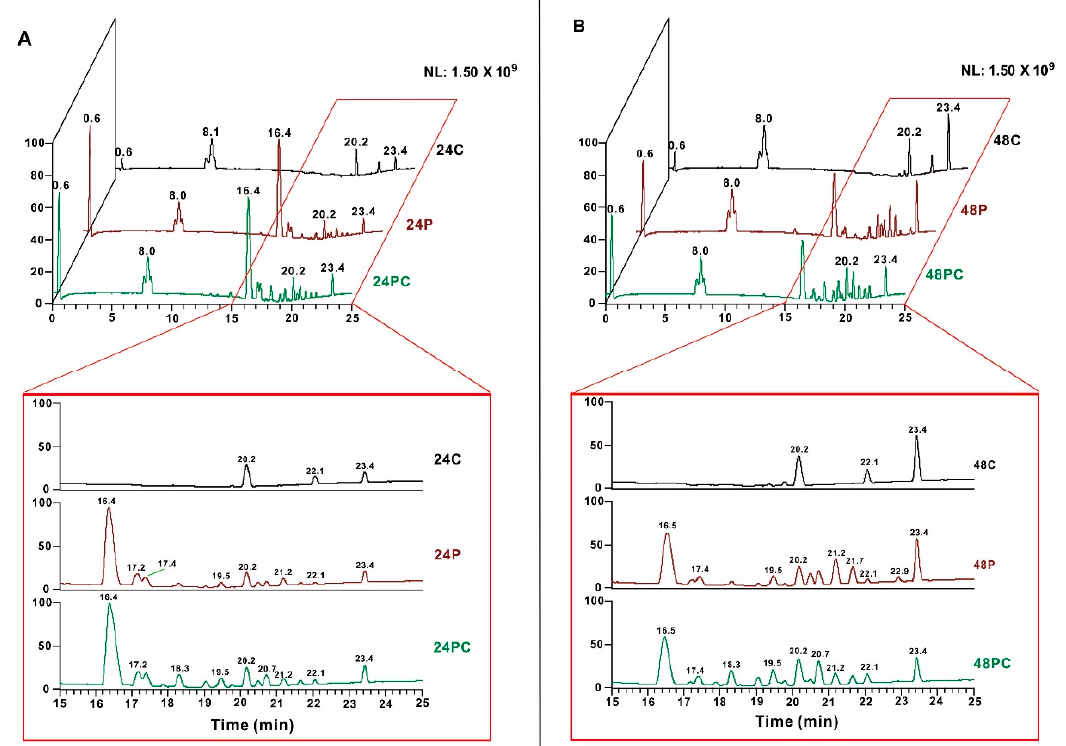
Figure 3. Chromatograms of interaction and control samples. ( A ) Base peak chromatograms of samples at 24 h: 24PC = experimental group, 24P and 24C = control groups. Red box shows chromatogram expansions. ( B ) Base peak chromatograms of samples at 48 h: 48PC = experimental group, 48P and 48C = control groups. Red box shows chromatogram expansions.